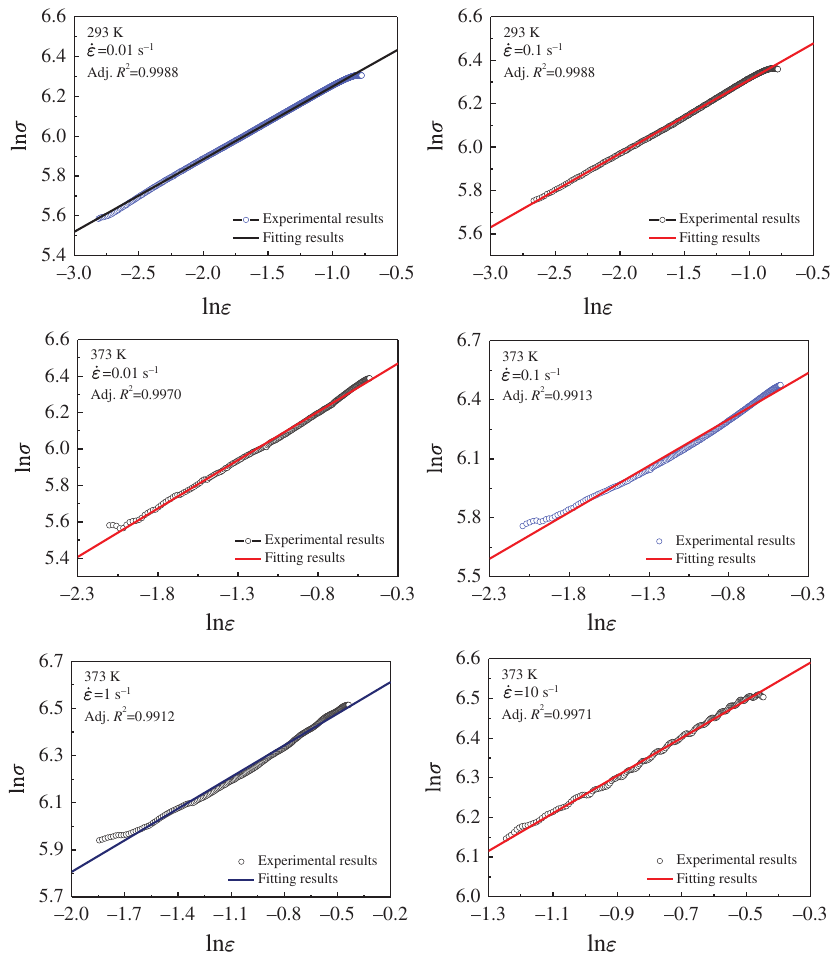
Figure 16: The relationships between ln σ -ln ε under low temperature region with diverse strain